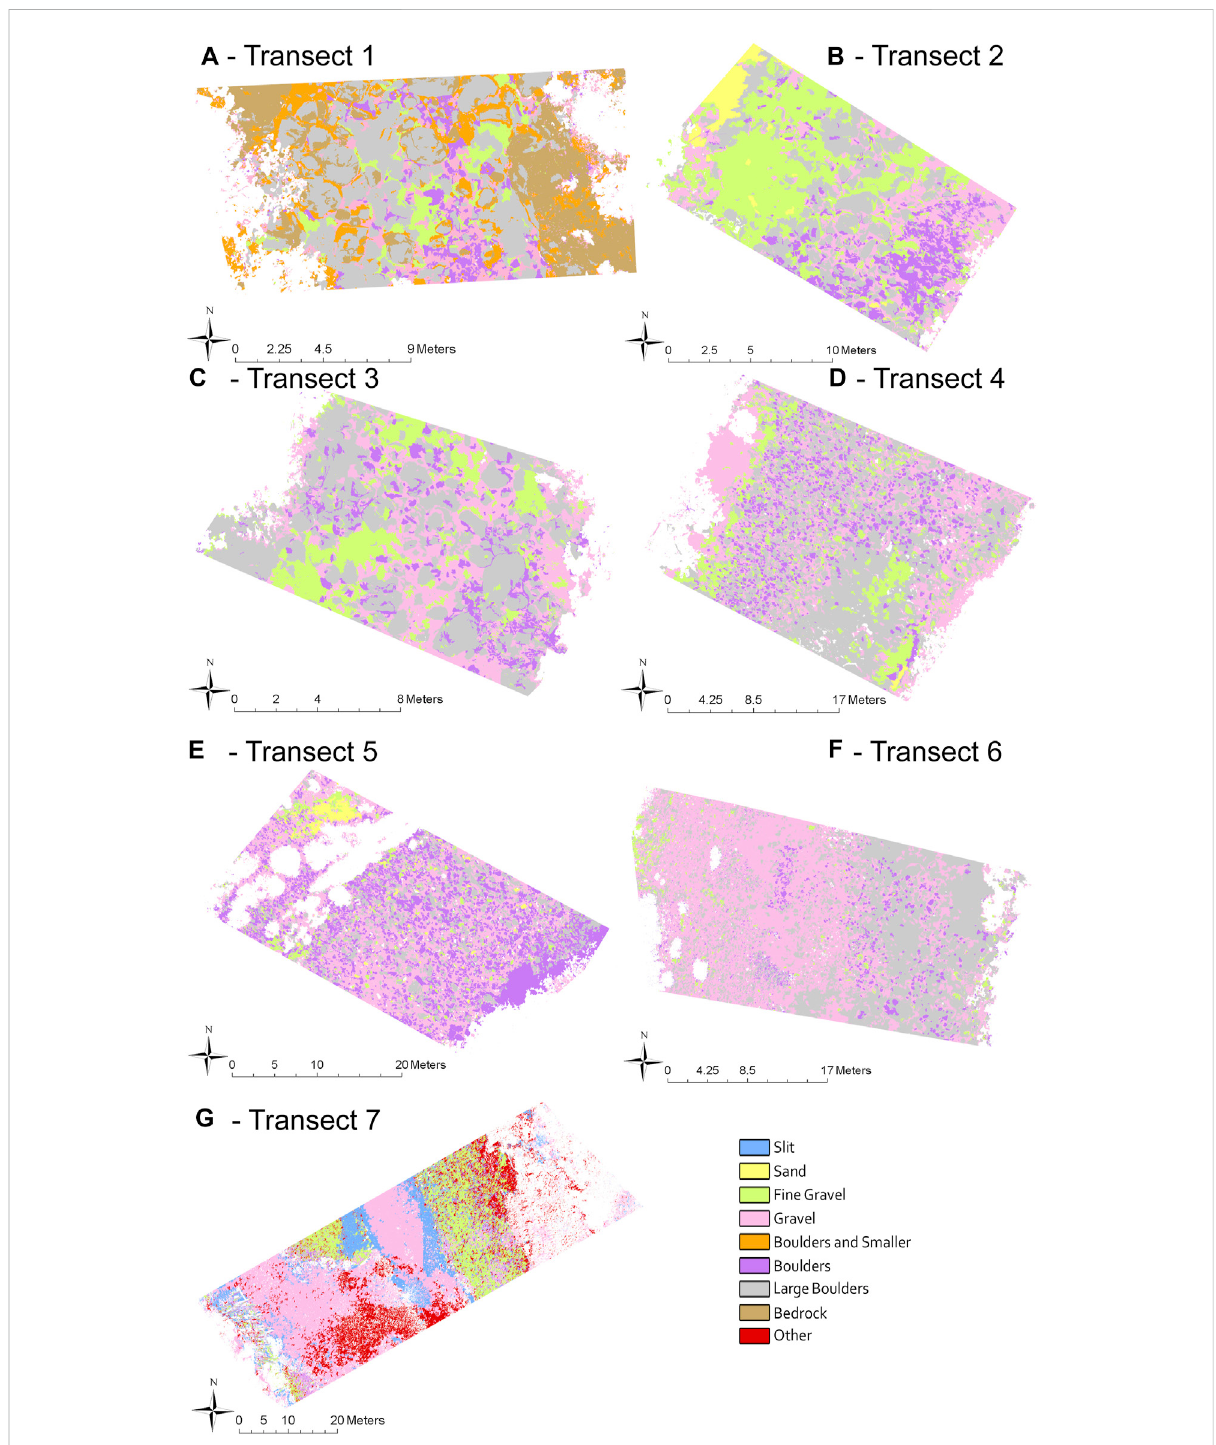
FIGURE 7 Substrate size of transects 1 – 7 (A – G) classi fi ed through OBIA. Substrate size includes “ other ” on transect 7 for submerged vegetation and “ boulder and smaller ” only used on transect 1 where fi ne substrate was limited. Submerged and dry substrate are analyzed separately but presented together for ease of